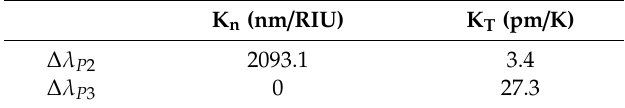
Table 4. Sensitivity coe ffi cients for the refractive index and temperature